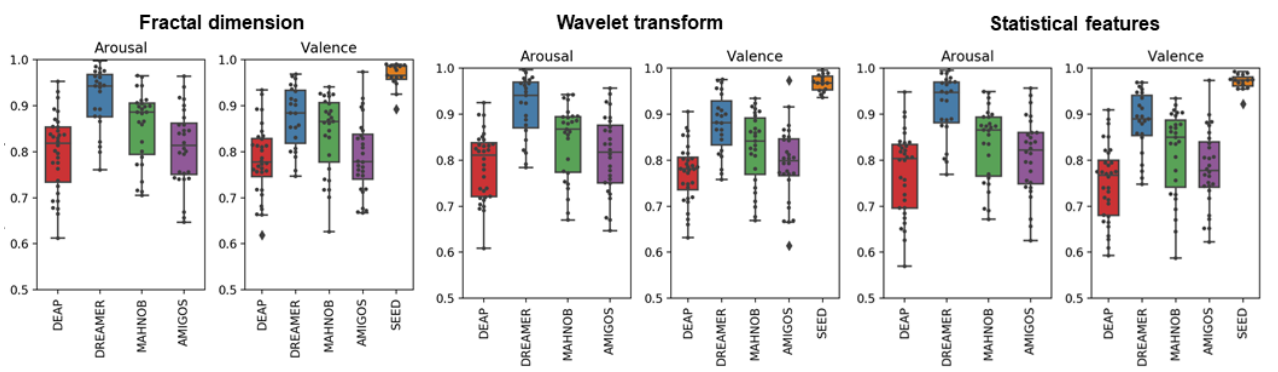
Figure 3. Top three feature sets. Boxplot of CART accuracy on each DEAP, DREAMER, MAHNOB, AMIGOS and SEED emotion dataset. X -axis represents the dataset name. Y -axis indicates the classification accuracy. Black dot in the figure represents average classification accuracy of each participant across